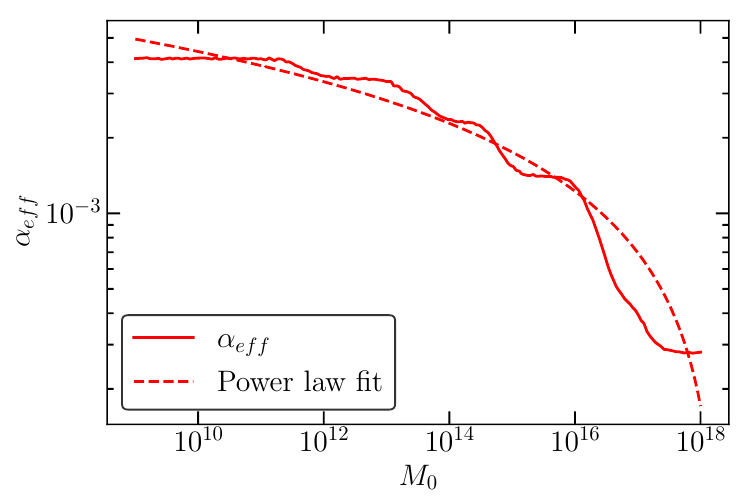
Figure 1: α as a function of initial black hole mass, with the power law fit given by eff Eq.